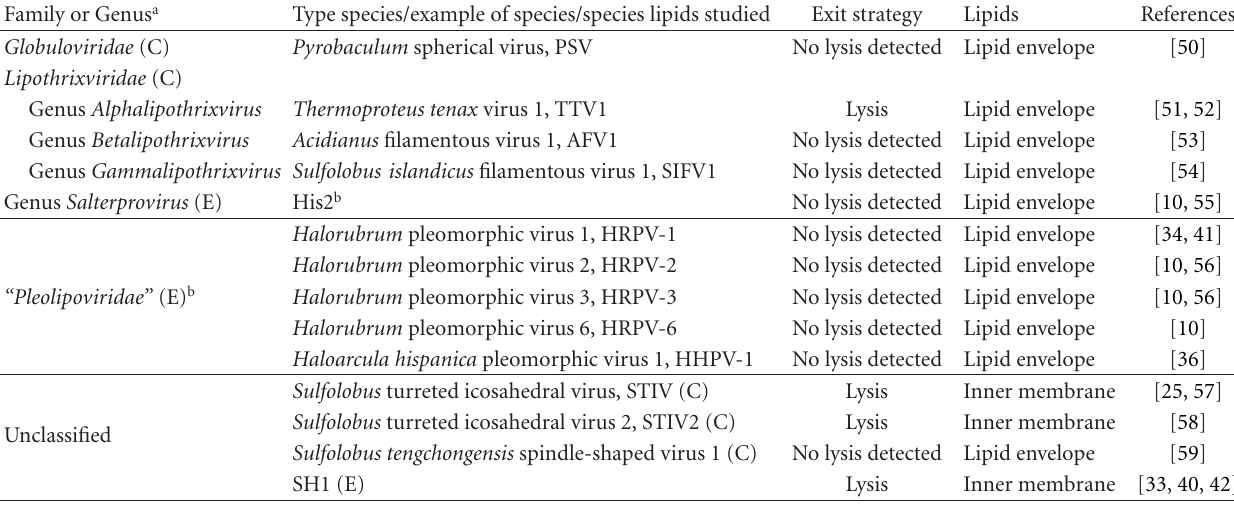
Table 1: Currently known membrane containing archaeal viruses, exit strategy, and presence of lipid envelope or inner